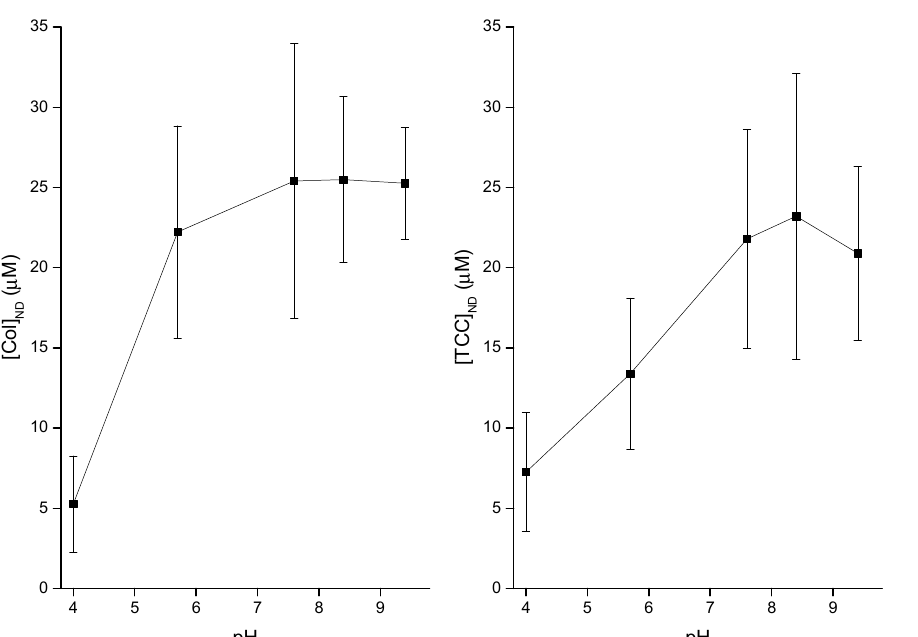
Figure 9. pH effects have been investigated on liposome binding of CDs, colchicine (Col) and TCC, while their concentrations in buffer are [Col] = 100 µ M and [TCC] = 100 µ M, respectively. Y-axis values are NanoDrop (ND) measured CD concentrations, which was detected directly at the liposomes using DDM. Different pH values have been obtained using the following conditions: pH 4, 5.7: 0.5 M NaCl + 20 mM acetate; pH 7.6, 8.4: 0.5 M NaCl + 20 mM Tris, pH 9.4: 0.5 M NaCl + 20 mM